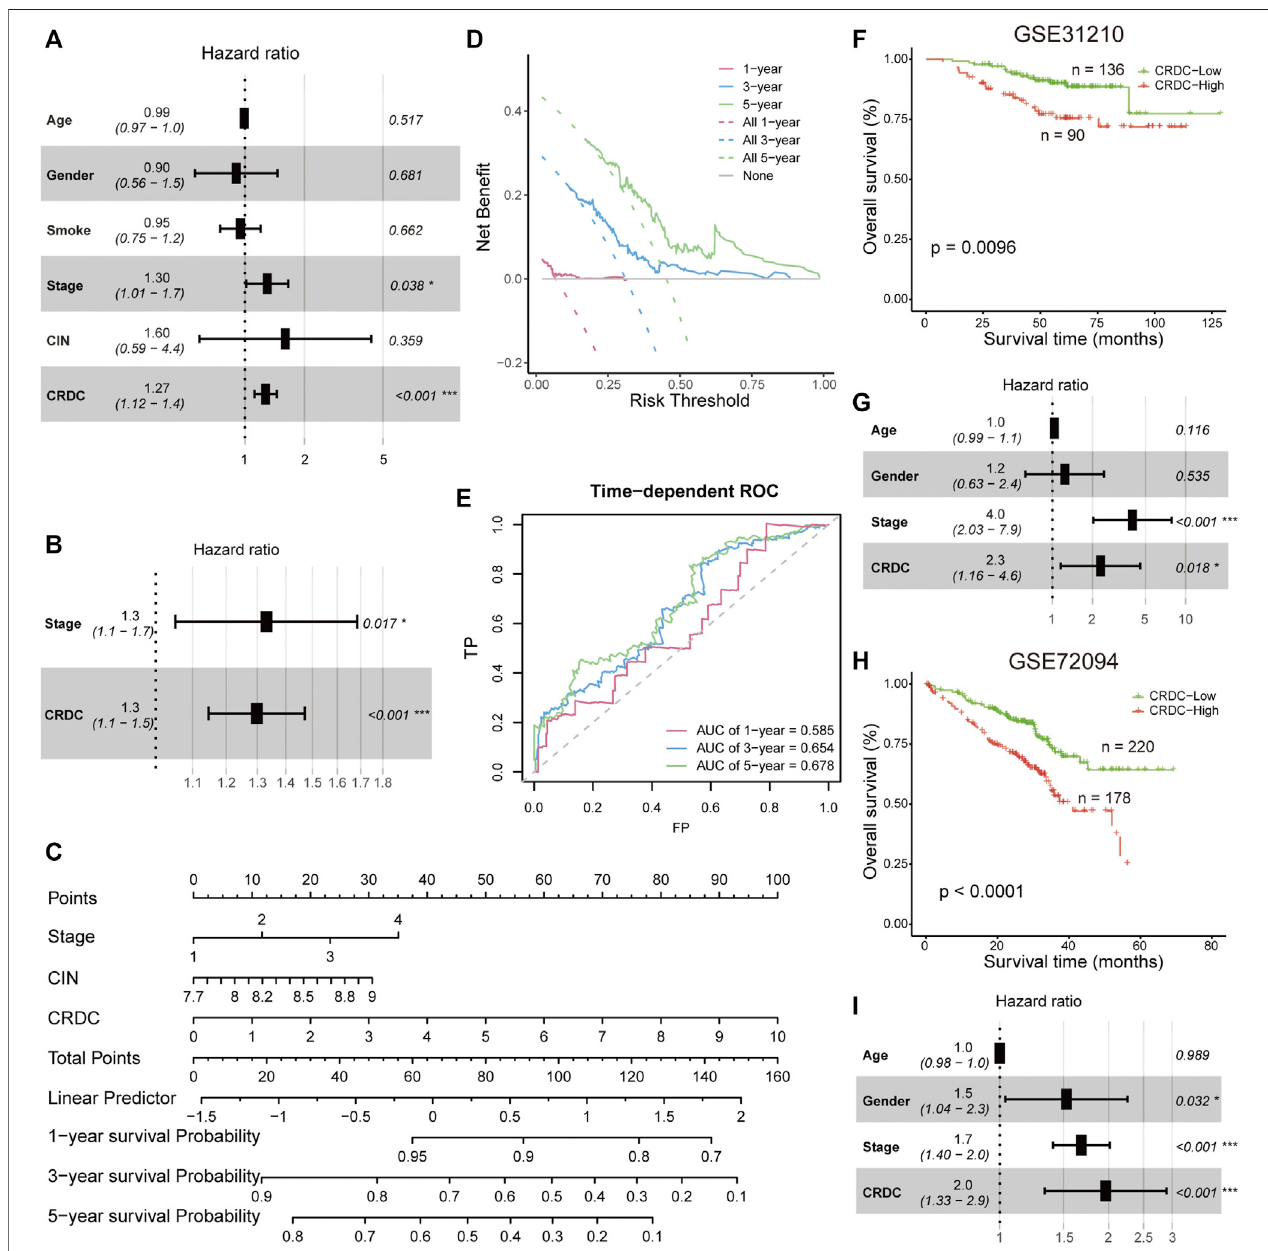
FIGURE 5 | Prognostic independence evaluation and external validation. (A) Forest plot for the multiple Cox proportional hazards model in TCGA patients. (B) ForestplotforthemultipleCoxproportionalhazardsmodelcontainedtheclinicalstageandCRDCriskscoreinTCGApatients (C) Nomogramconstructedbytheclinical stage and CRDC riskscore for predicting 1, 3, and 5 years DSS. (D) Decision curve ofthe nomogram for 1, 3, and 5 years DSS. (E) Time-dependent ROCof the CRDC riskscoreforpredicting1,3,and5 yearsDSSoutcome.Kaplan – Meiersurvivalcurves ofCRDC-High andCRDC-Lowpatients andforestplotsforthemultipleCox proportional hazards model in (F,G) GSE31210 and (H,I) GSE72094